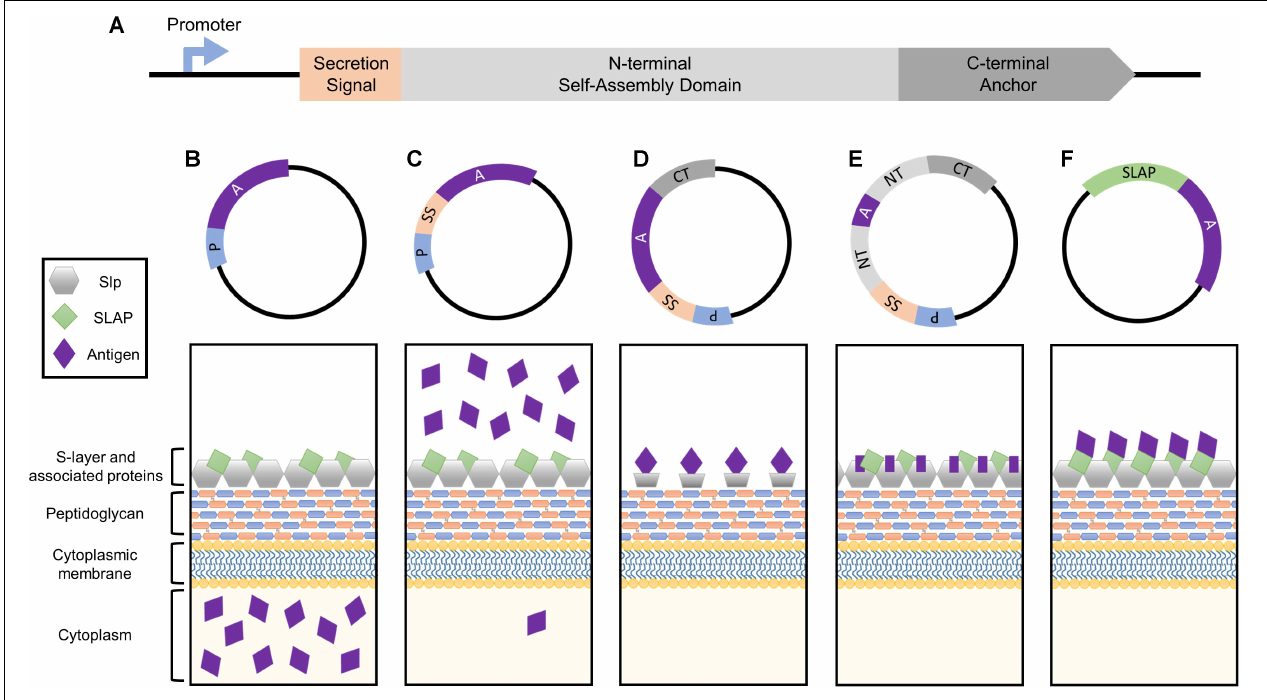
FIGURE 1 | Simplified depiction of the genetic components comprising the Slp protein and how they can be harnessed for heterologous protein expression systems. (A) The genetic building blocks of an S-layer gene, including the promoter, secretion signal peptide, N-terminal self-assembly domain, and C-terminal peptidoglycan anchor. Each can be harnessed together or separately for antigen and biotherapeutic delivery applications. (B) The Slp promotor induces the production of high levels of target protein which will accumulate within the cytoplasm of the host bacterium. (C) The Slp secretion signal yields robust secretion of antigen into the extracellular environment. (D) Cell surface display of a foreign peptide can be achieved via fusion to an Slp anchoring domain (N- or C- depending on species). (E) The highest levels of antigen expression and cell surface display can be obtained via direct integration into the Slp, but epitope size is extremely limited in order to maintain array formation. (F) A novel display strategy utilizing S-layer associated protein (SLAP) fusions which theoretically enable the surface display of much larger